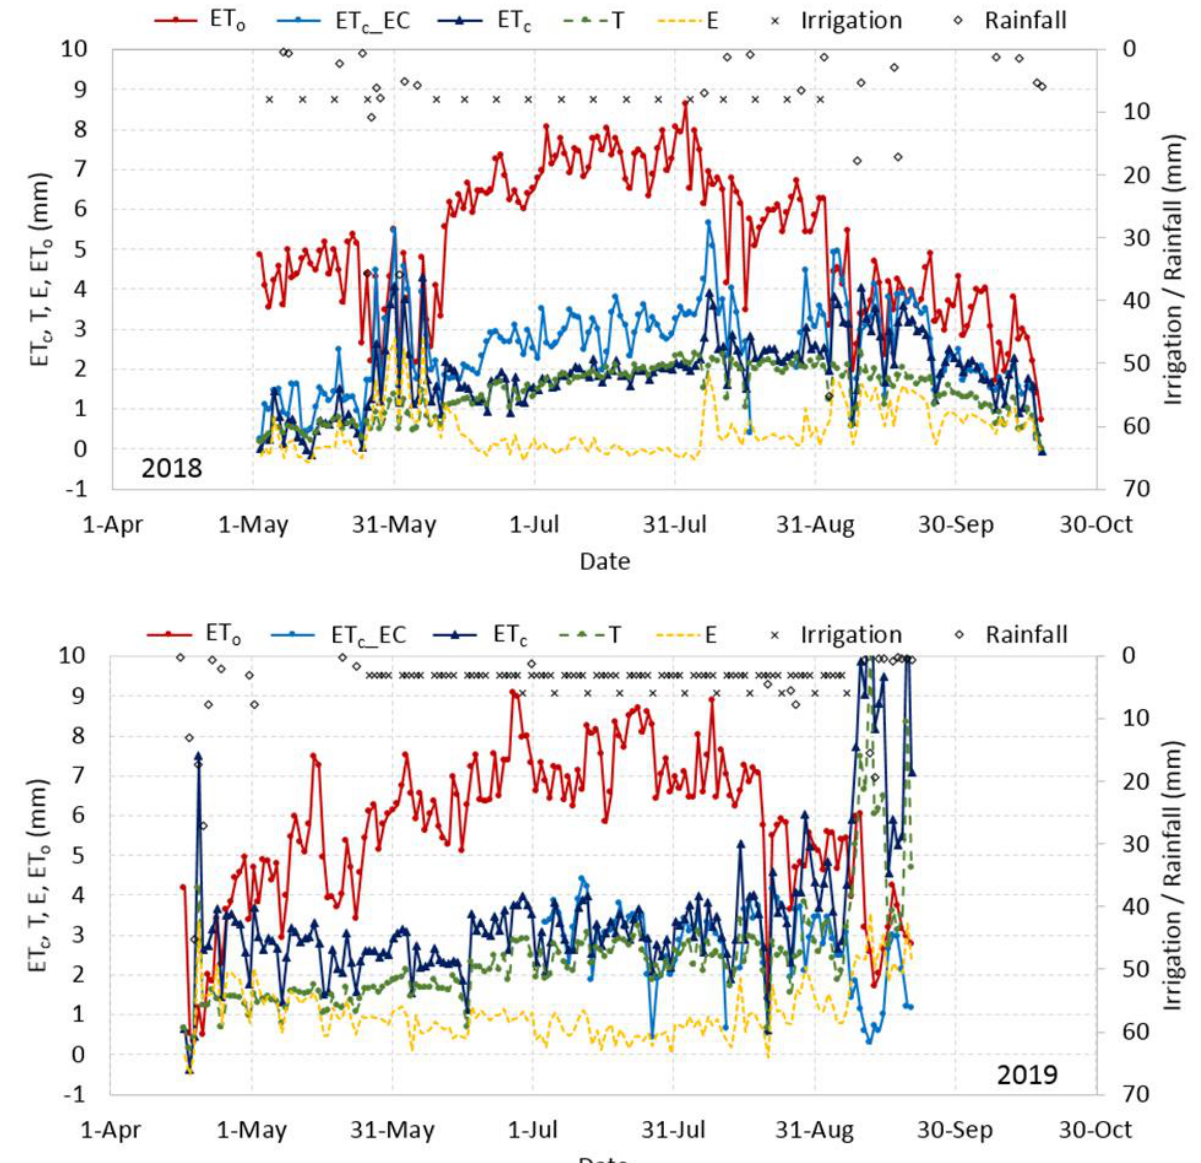
Figure 8. Evolution of daily crop evapotranspiration, ET c , evaporation, E, and transpiration, T, for the 2017–2019 growing seasons. Reference crop evapotranspiration, ET o , together with irrigation and rainfall water amounts, is also plotted. ET c_ EC corresponds to corrected (RE) eddy-covariance measurements.